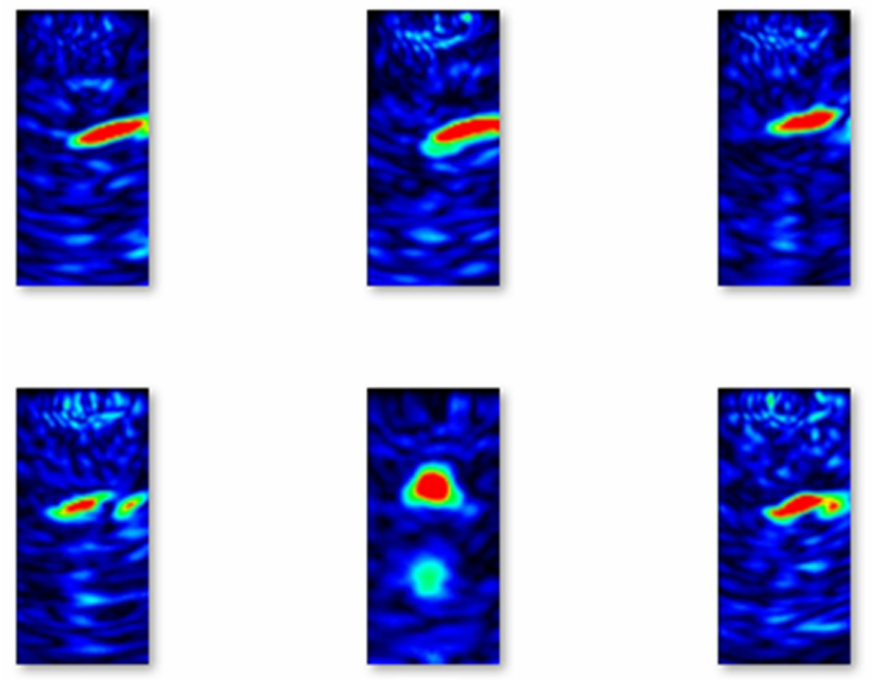
Figure 6. Selected examples of B-scans with flaws from the training